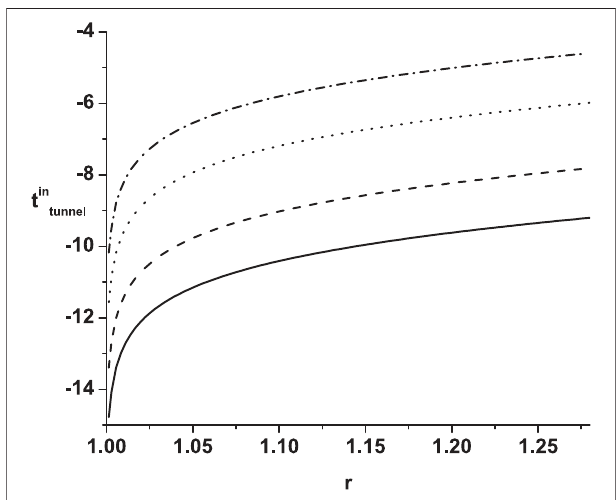
FIGURE 6 | A falling particle tunnels through the horizon at moment t in tunnel . The tunneling time depends on the wave packet ’ s momentum uncertainty, Δ P X . The momentum uncertainty of the solid line, dashed line, dotted line and dashed-dotted line are Δ P X = 0.01, 0.05, 0.02, 0.1 respectively. If the particle is close to the horizon, it can tunnel easier through the horizon. If the momentum uncertainty is smaller, the tunneling is, again, easier.